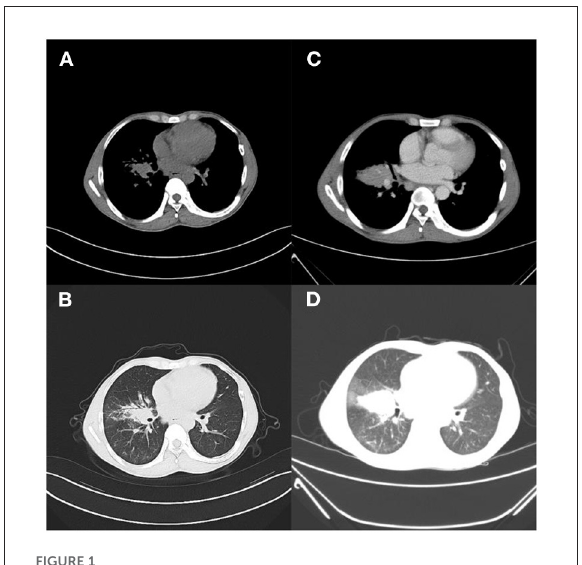
FIGURE1 Case 1. (A,B) Outpatient lung CT; (C,D) 9 days after admission, pulmonary inflammation worsened, nodules increased, and lymph nodes were more enlarged.